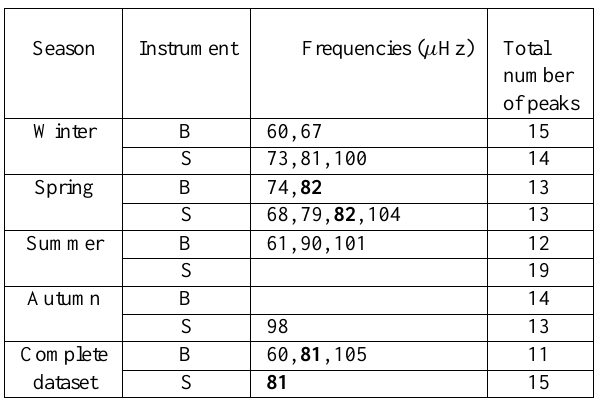
Table 3. Frequencies of oscillations in the 2.5 − 5h period sub- range, measured by microbarograph (B) and seisomogaraph (S) at St.Petersburg (60 ◦ N, 30 ◦ E). The table shows the oscillations which exceed the 10% probability level (see Appendix).